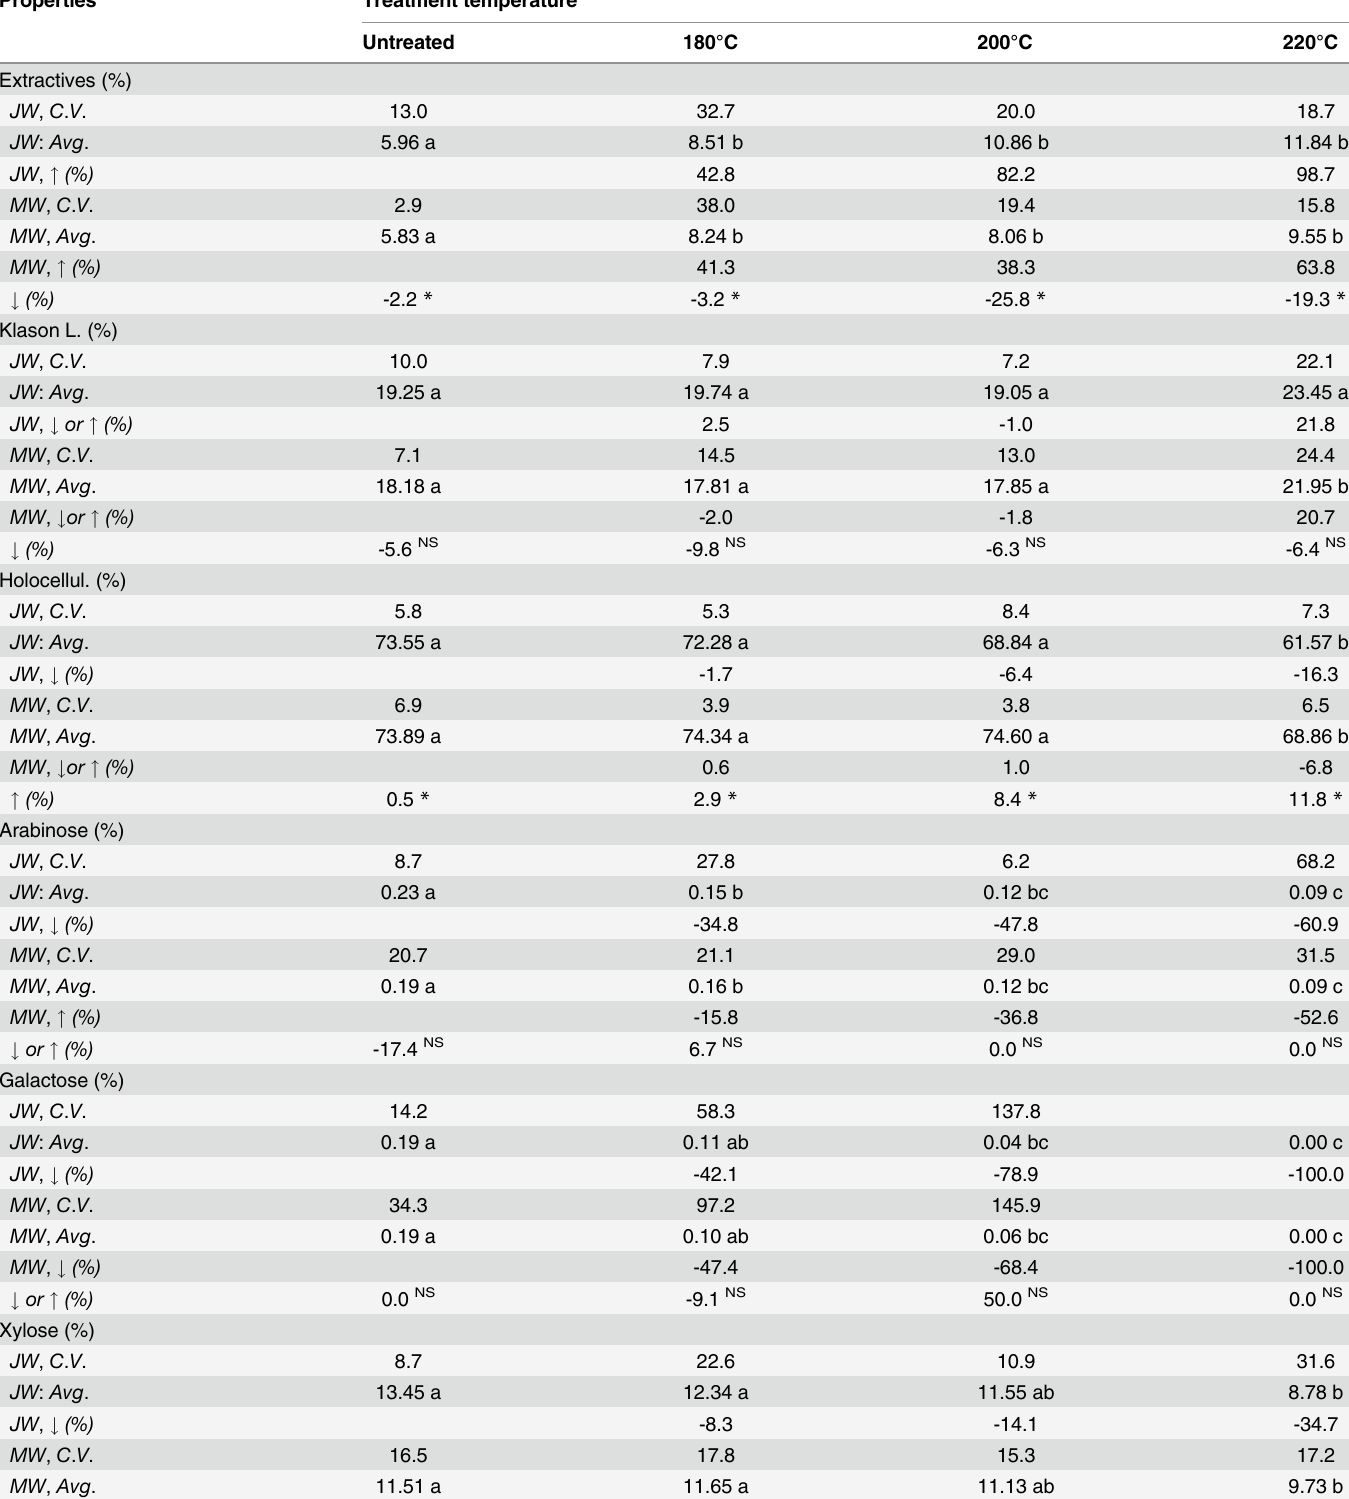
Table 1. Chemical properties of juvenile and mature woods of Hevea brasiliensis thermally modified at various temperatures.